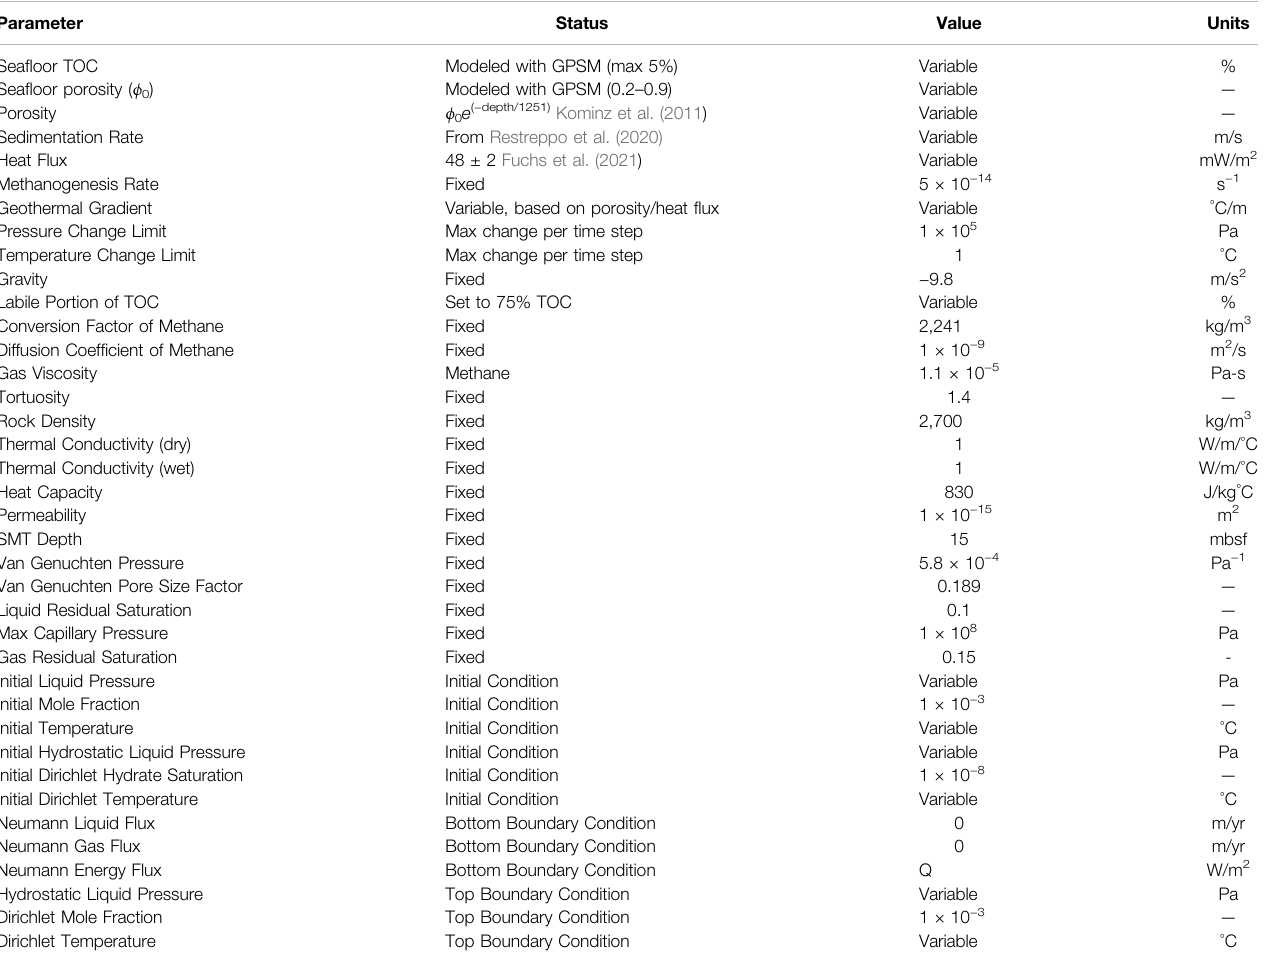
TABLE 1 | Input parameters for Dakota and